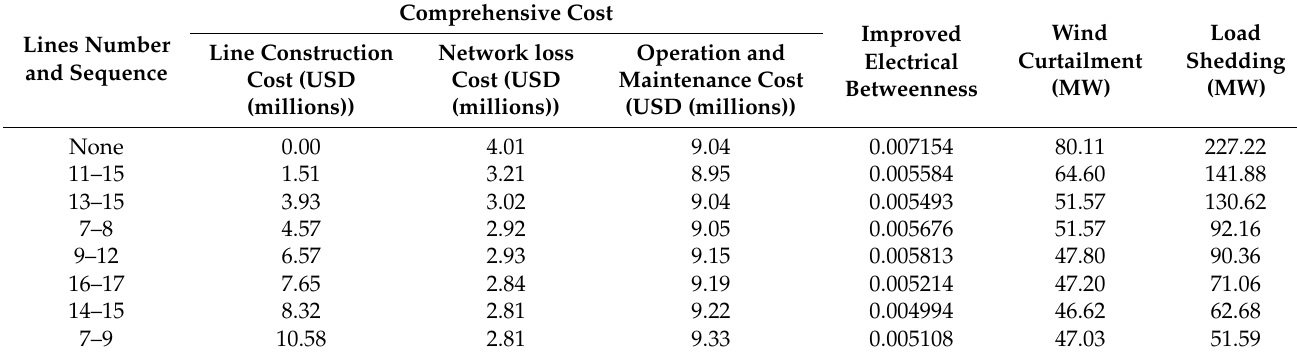
Table 6. TNEP scheme of DQN in modified IEEE RTS-24 bus system.